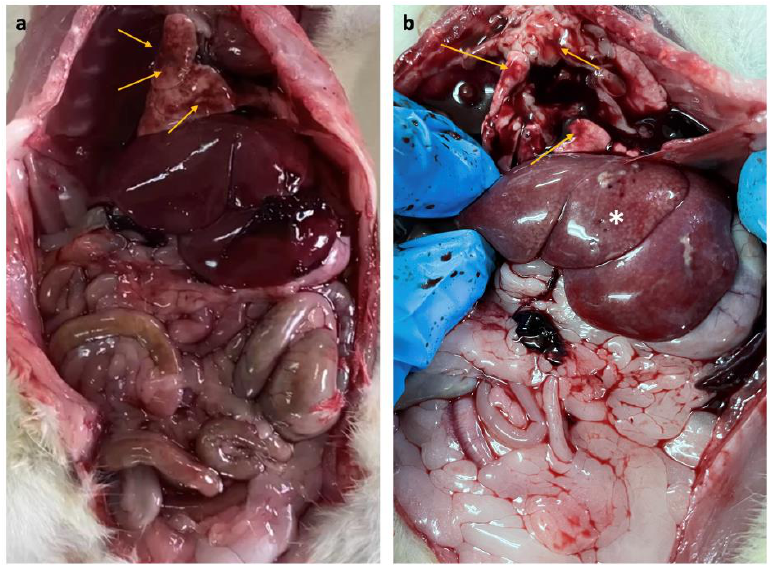
Figure 3. ( a ) Gross pathology of rats after two months of whole-body exposure to 150 kHz IF EMR showing multifocal and diffuse congestion (arrows) in the lung of the control and EMR groups, ( b ) multifocal and diffuse congestion (arrows) in the lung, inflammatory changes in the liver (asterisk) were observed only in the EMR group.